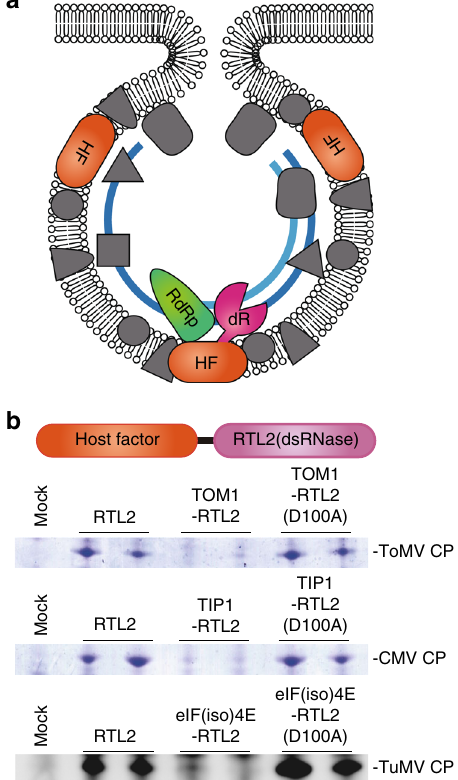
Fig. 6 Targeted inhibition of virus multiplication by dsRNases fused with host factors involved in viral RNA replication. a Working model for targeted inhibition. By fusing a dsRNase (dR) with host factors (HF) included in the viral replication complex, dsRNase is delivered into the replication compartment. b Inhibition of multiplication of three different viruses by dsRNases designed to target the replication complexes of each virus. Accumulation of coat proteins (CP) in inoculated leaves was examined by Coomassie staining (ToMV and CMV) or western blotting (TuMV) at 2 – 4 dpi. The RTL2 (D100A) constructs contain a catalytic mutation in RTL2. The source data of Fig. 6b are provided as a Source Data fi